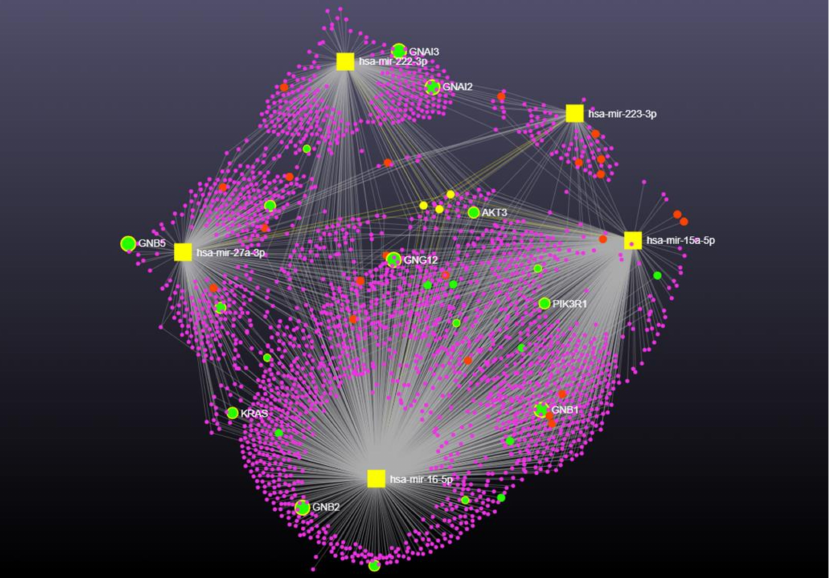
Figure 4. Network visualization for the enrichment analysis of miR-223-3p, miR-15a-5p, miR-222-3p, and miR-16-5p in GRN and MAPT FTD group. Yellow squares represent miRNAs, and pink circles are their targets. In particular, yellow circles represent the shared interactions between miR-155-5p, miR-106b-5p, and miR-15a-5p. Chemokines signaling target genes are represented in red, whereas Synaptic vesicle cycle, GABAergic synapse, and cholinergic synapse target genes are highlighted in